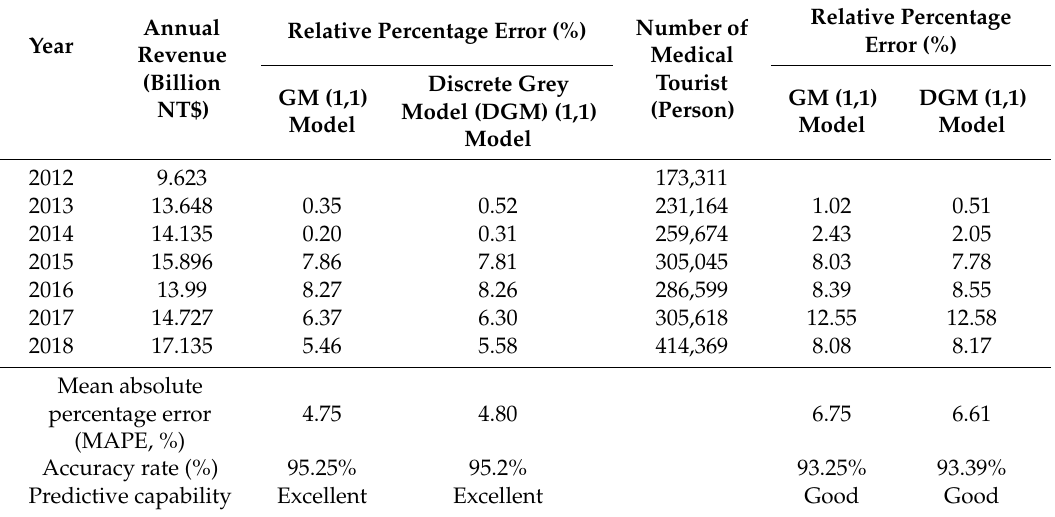
Table 5. Performance of proposed